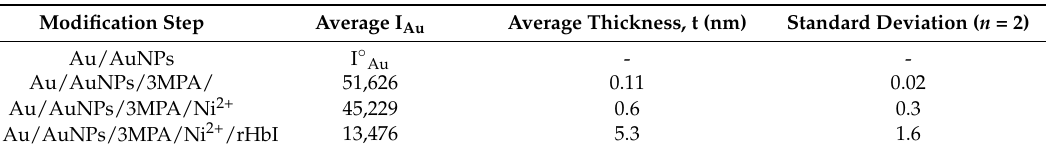
Table 1. Attenuation of Gold Substrate Peak Intensities and Overlayer thickness t in each modification step.